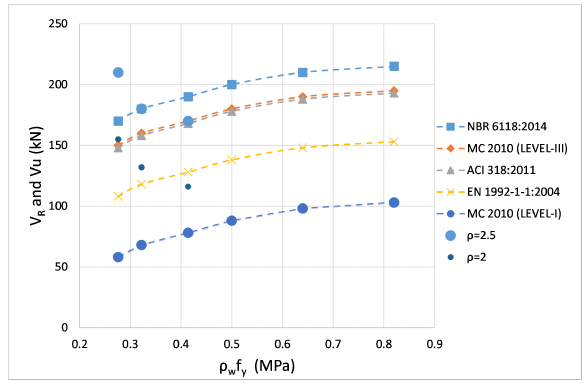
Fig. 5. Deflection Vs shear strength at critical shear span